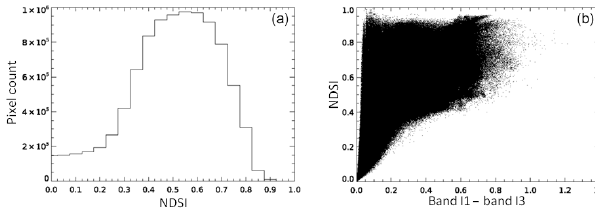
Figure 5. NDSI histogram (a) and scatterplot of NDSI versus VIS- SWIR difference (b) for the VIIRS 5 December 2014, 19:45UTC image in Fig. 3. Pixels restricted to snow only, i.e., NDSI > 0.0 and not masked as cloud in the NDSI_Snow_Cover dataset. Histogram was calculated with NDSI bin size of